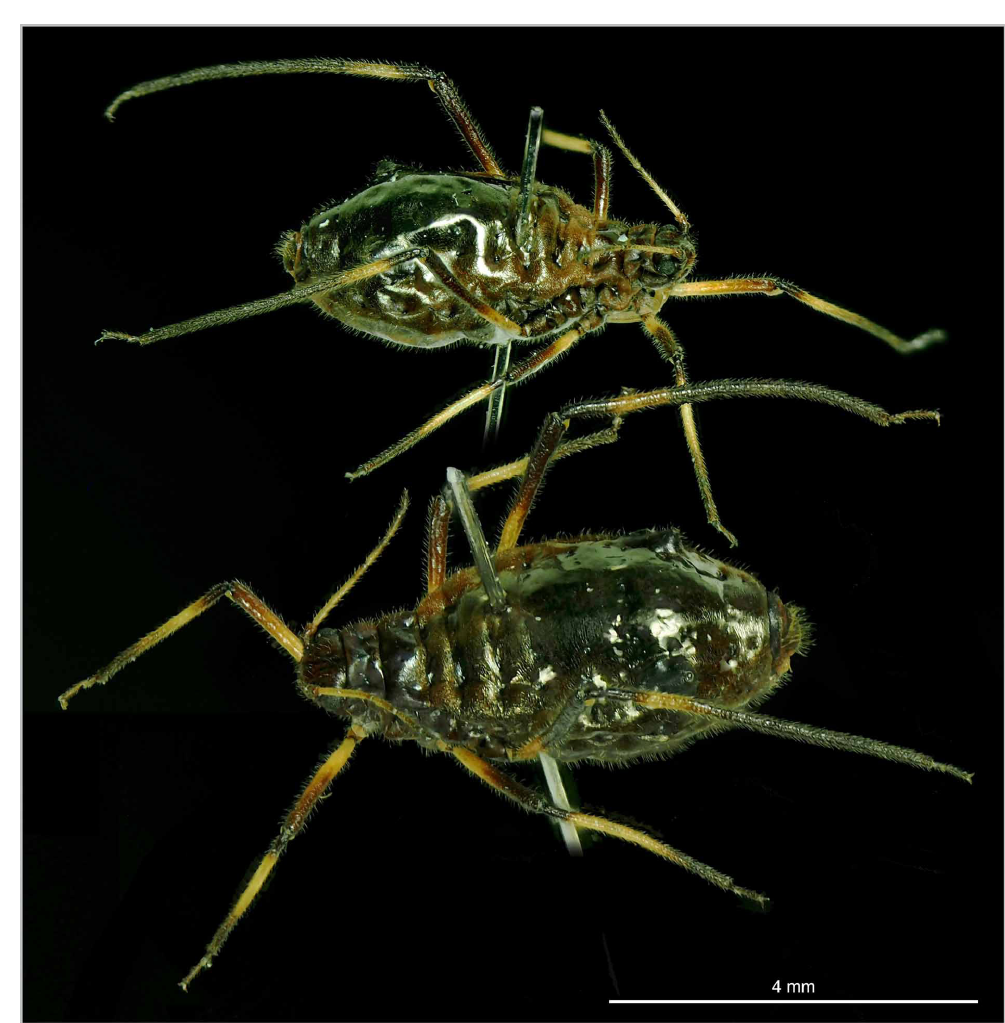
Fig. 97. Cinara (Cinara) nuda Mordvilko, 1895. Apterae (freeze-dried specimens).